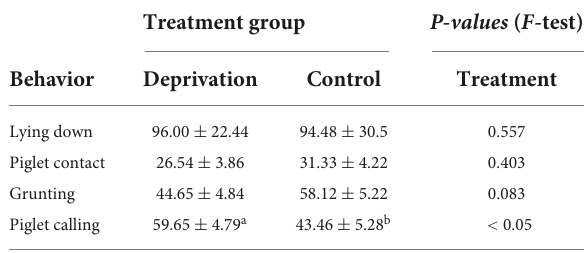
TABLE 2 Relative frequencies (%) of behaviors of sows and piglets preceding the first three suckling acts after the end of the deprivation procedure.